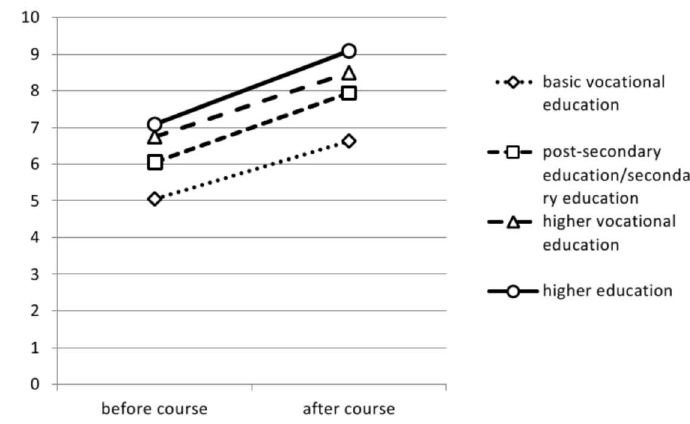
Figure 5a. Mean values of the level of participant knowledge concerning children’s eating behaviors before and after the course, according to level of education